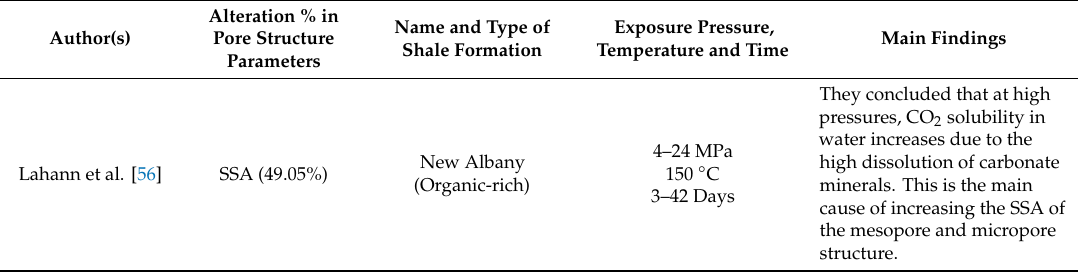
Table 1. Summary of recent studies highlighting the e ff ect of CO 2 injection on pore